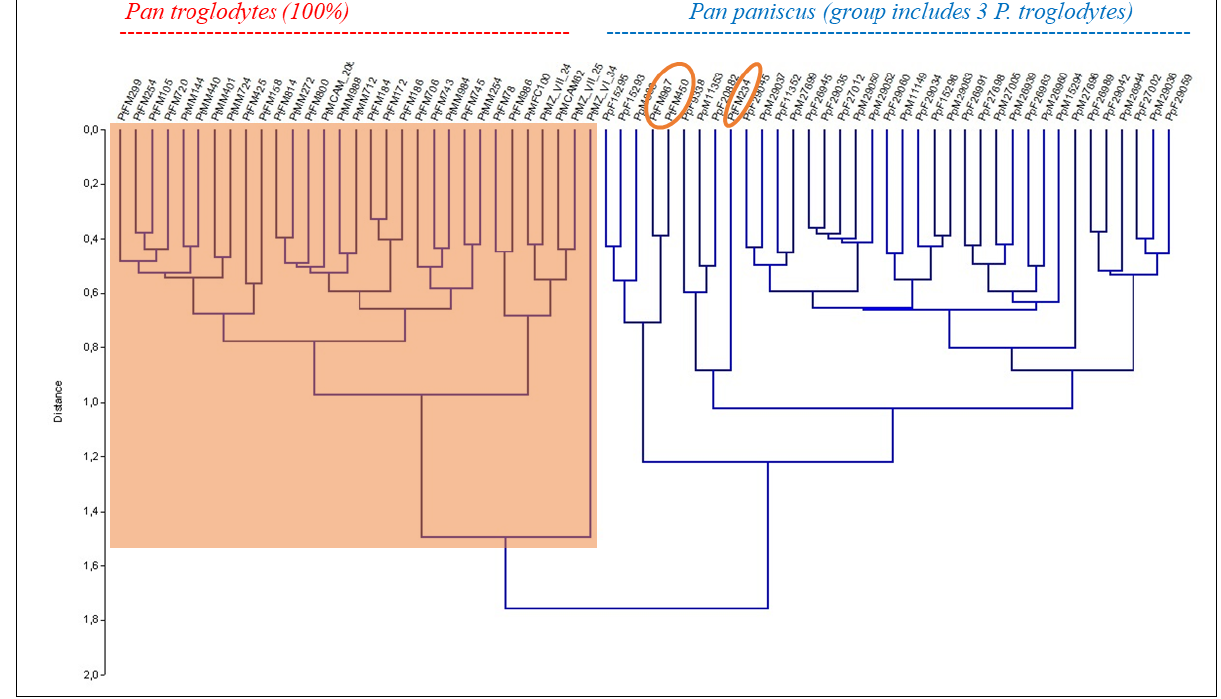
Figure 2: Phenetic tree obtained from UPGMA cluster analysis of log sem statistics based on pairwise linear regression analyses of cranial measurements of two chimpanzee species, Pan troglodytes ( n =38 specimens) and P. paniscus ( n =38 specimens). Measurements for specimens numbered here have been published by Gordon and Wood 11 . Log sem statistics generally distinguish between the two taxa.